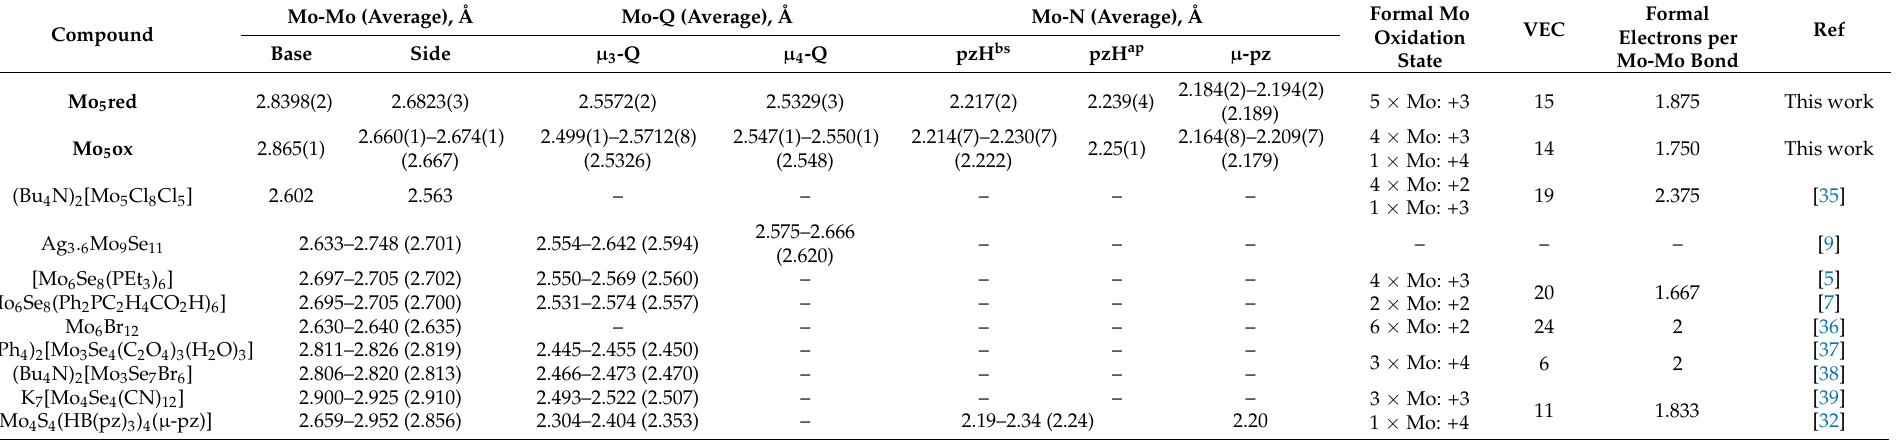
Table 1. Selected interatomic and average distances (Å), oxidation state, and valence electrons per cluster (VEC) for Mo 5 red and Mo 5 ox in comparison with literature